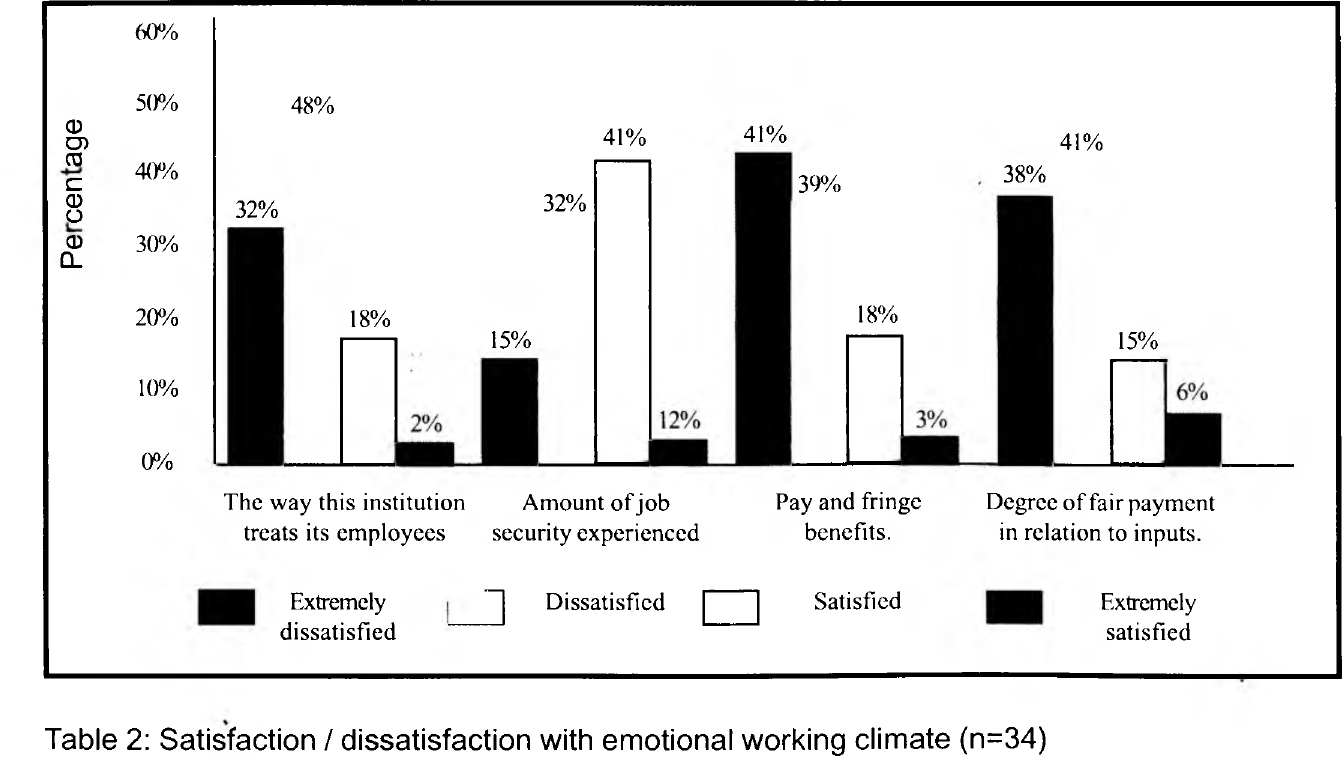
Table 2: Satisfaction / dissatisfaction with emotional working climate